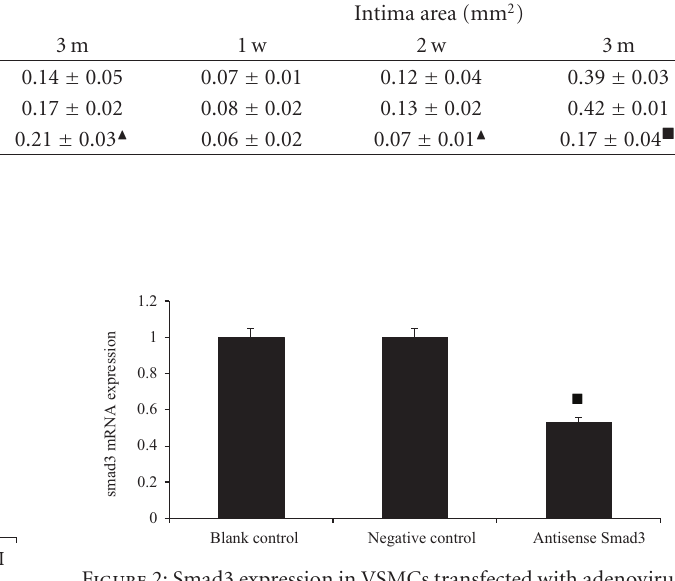
Figure 2: Smad3 expression in VSMCs transfected with adenovirus expressing antisense Smad3 in vitro . Following injury, VSMCs were collected and divided into 3 groups. In the antisense Smad3 group, cells were transfected with adenovirus expressing antisense Smad3; in the negative control group, cells were transfected with blank adenovirus; in the blank control group, cells received no treatment. Transfection was done with adenovirus at an MOI of 100 pfu. Three days later, total RNA was extracted from each group and RT-PCR was performed. The mRNA expression of Smad3 was normalized to that of β -actin. The mRNA expression of Smad3 in the blank control group served as the baseline level, and the mRNA expression of Smad3 in other groups was normalized to that in the blank control group as the fold change which was used for delineation. Data were expressed as mean ± SD. (cid:2) P < 0 . 05, (cid:3) P < 0 . 01 versus negative control